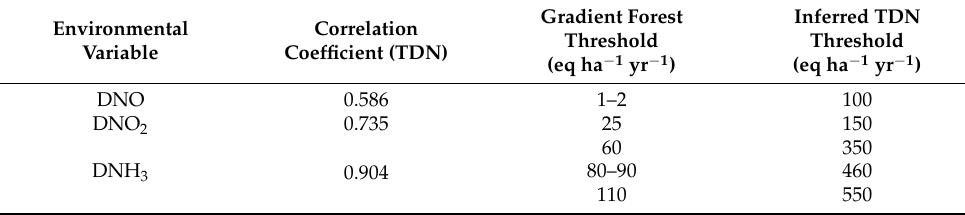
Table 5. Nitrogen deposition variables evaluated for correlation. Highly correlated gradient forest thresholds were used to infer TDN